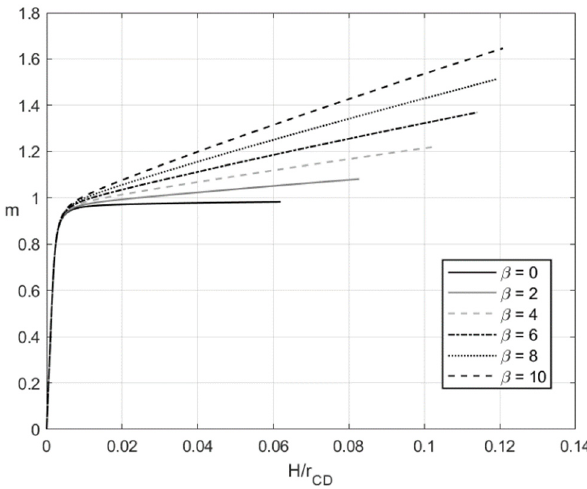
= H r = H r at 0.2 f and sev- at 0.2 f and sev-